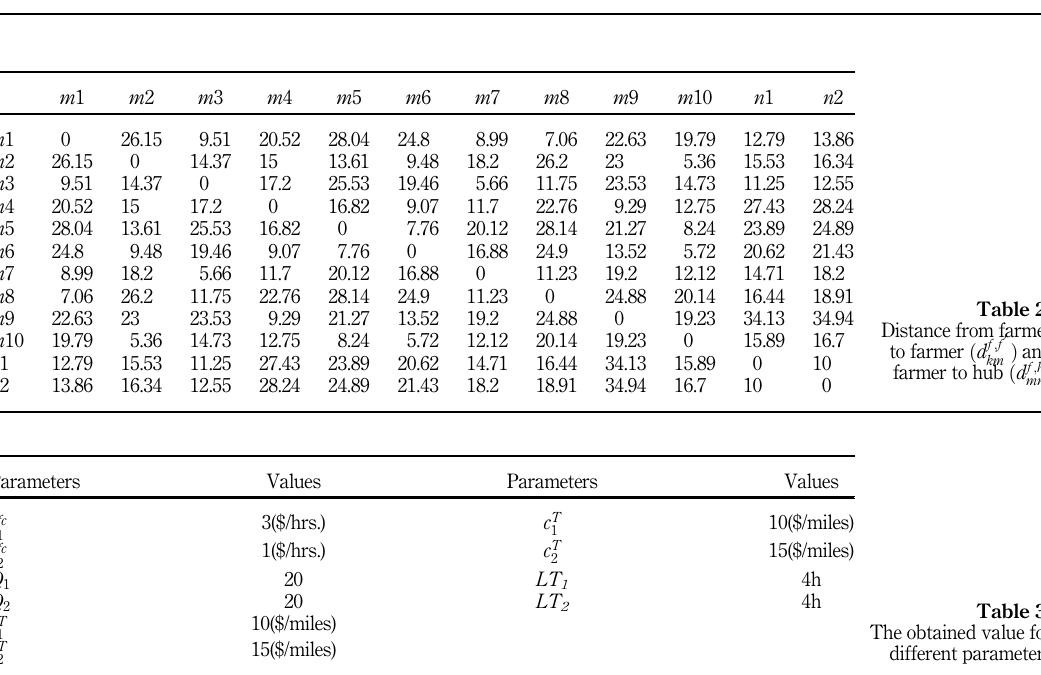
Table 1. The supply of